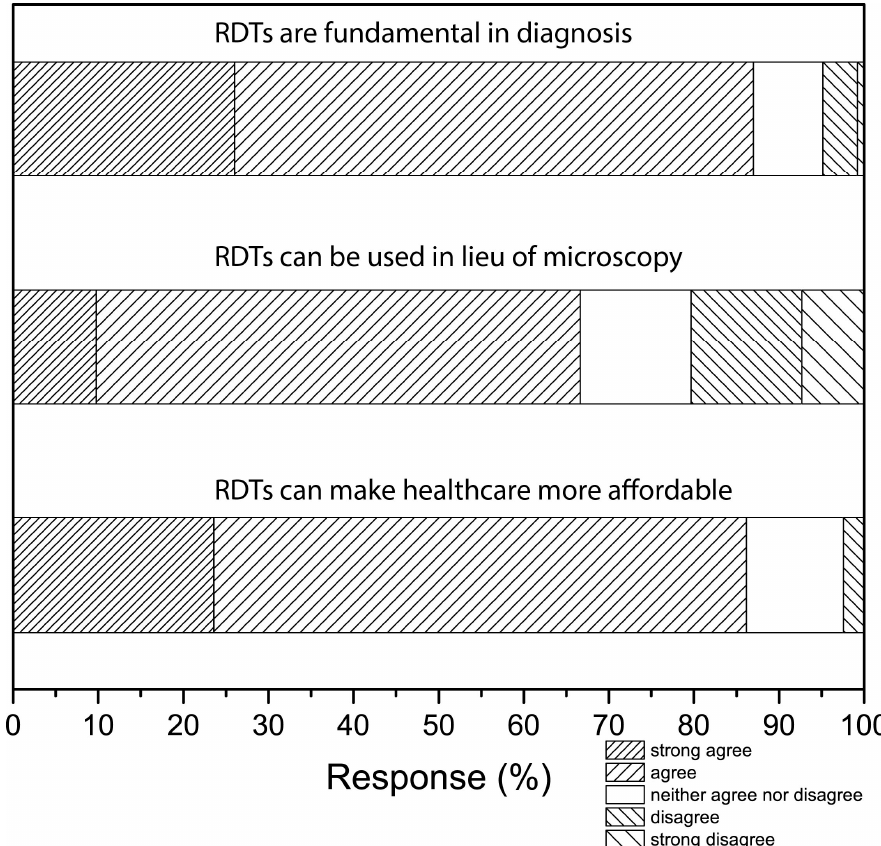
Figure 2. Response to qualitative questions, with the question re-phrased on top of the responses. Affirmative responses are given on the left, while negations are given on the right. The unmarked regions represent number of neutral responses.